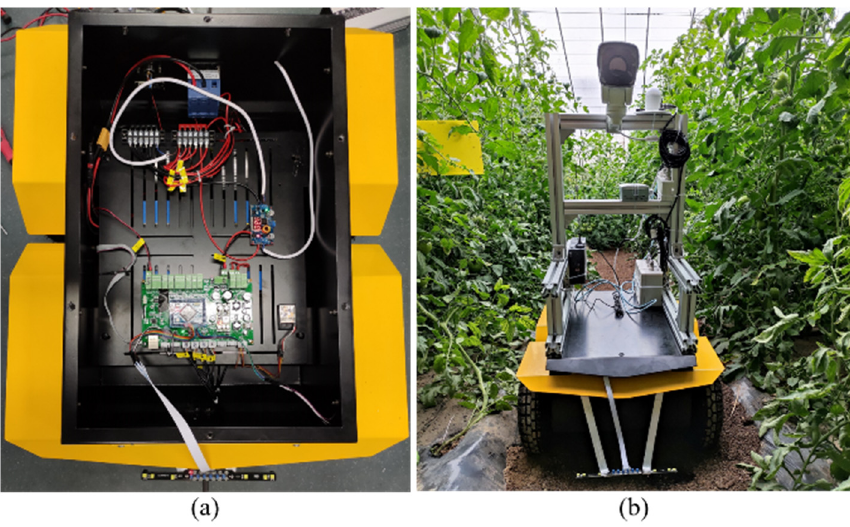
Figure 1. The ( a ) internal components and ( b ) working condition diagram of the greenhouse mobile robot.